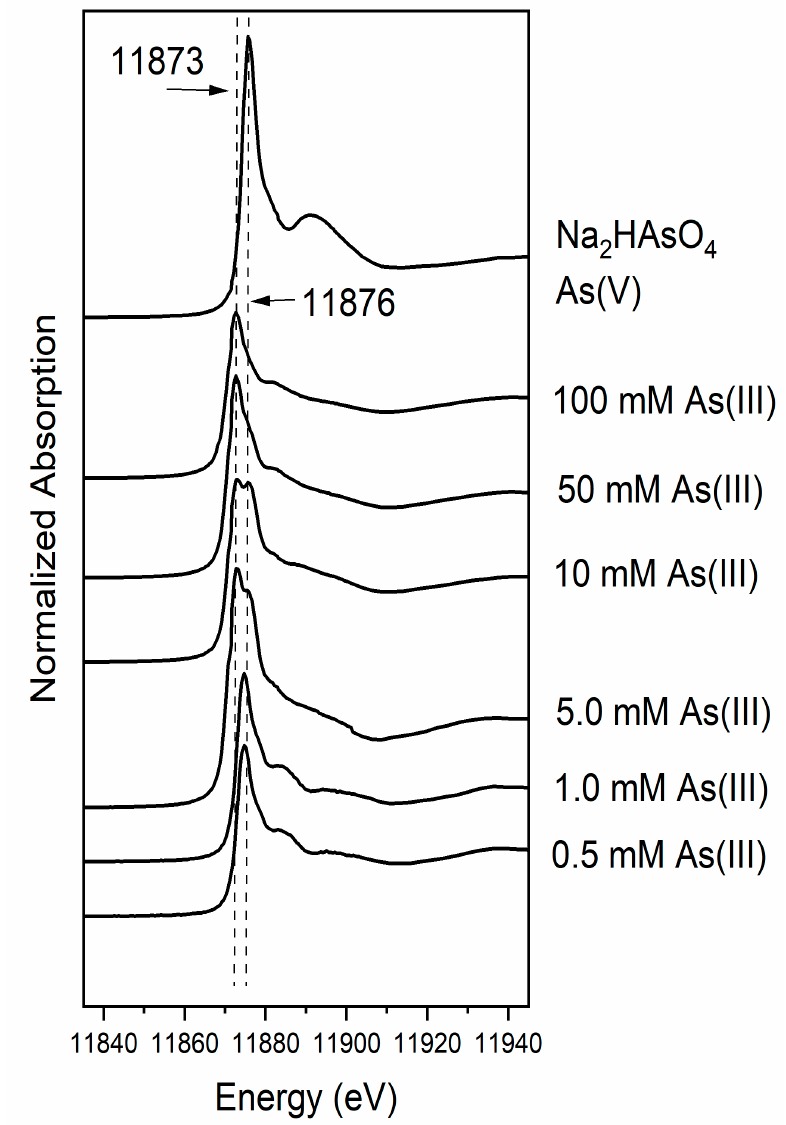
Figure 3. Normalized As XANES spectra and quantitative fit deconvolutions with reference As(V) (11876 eV; white line) and As(III) (11873 eV; white line) and spectra for coprecipitates at various initial As(III) concentrations (0.5 − 100 mM).